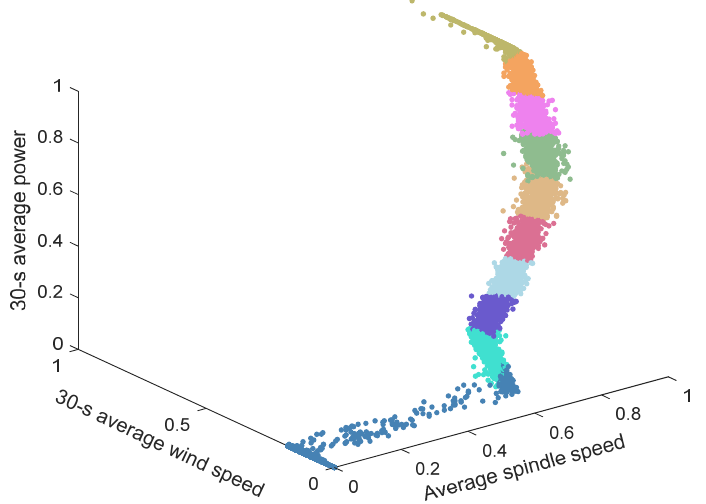
Figure 11. Three-dimensional plot of the working conditions after division.